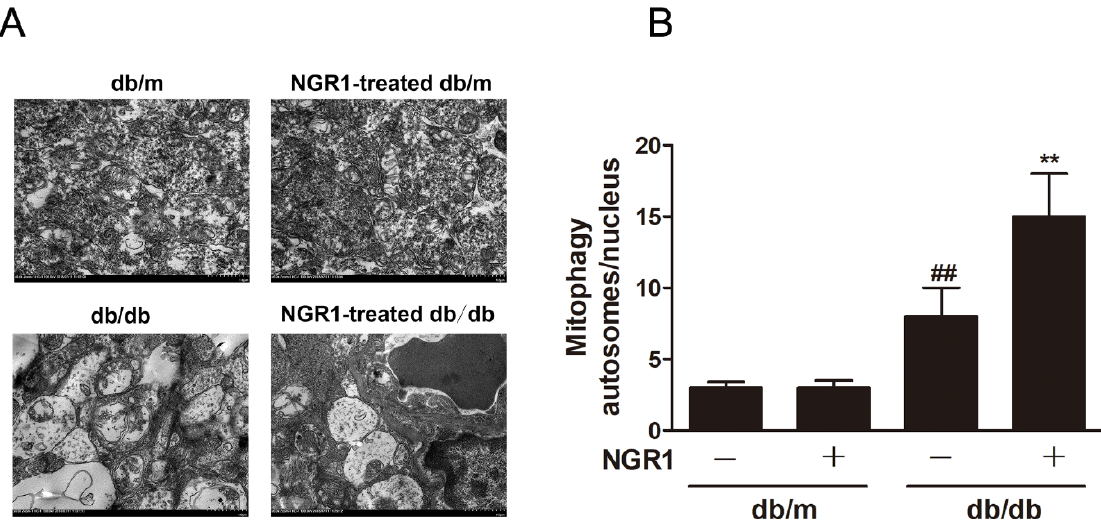
Figure 7. NGR1 pretreatment enhanced mitophagy in diabetic db/db mice with diabetic